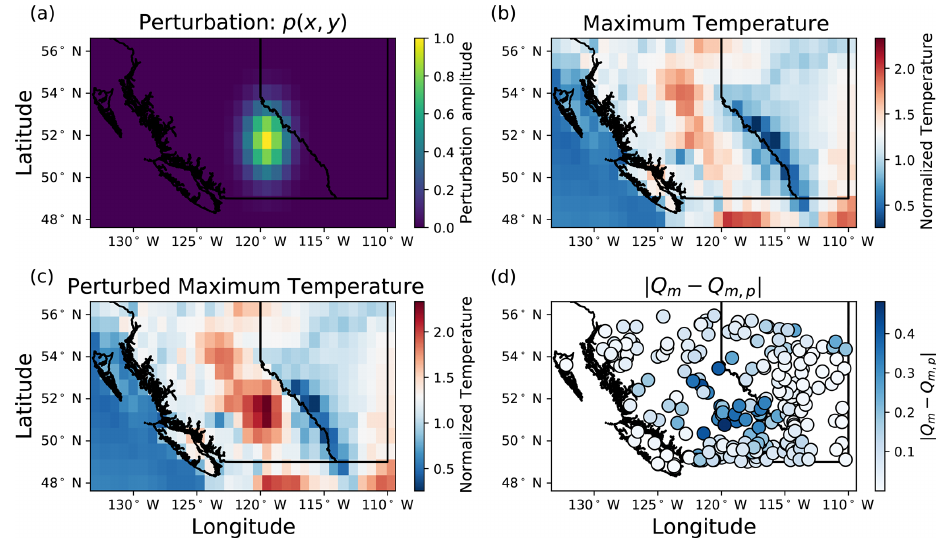
Figure A4. Perturbing the maximum temperature field of 1d. (a) The perturbation to be added to the test weather data. (b) The unperturbed maximum temperature field for 3 August 2011. (c) The perturbed maximum temperature field for 3 August 2011. (d) The magnitude of the difference between the unperturbed streamflow and the perturbed streamflow, averaged across all model runs.